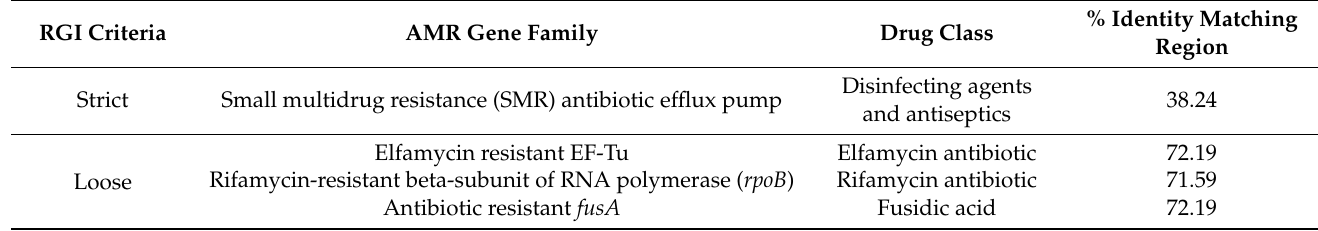
Table 3. Results of ARG analysis based on genome sequencing data.